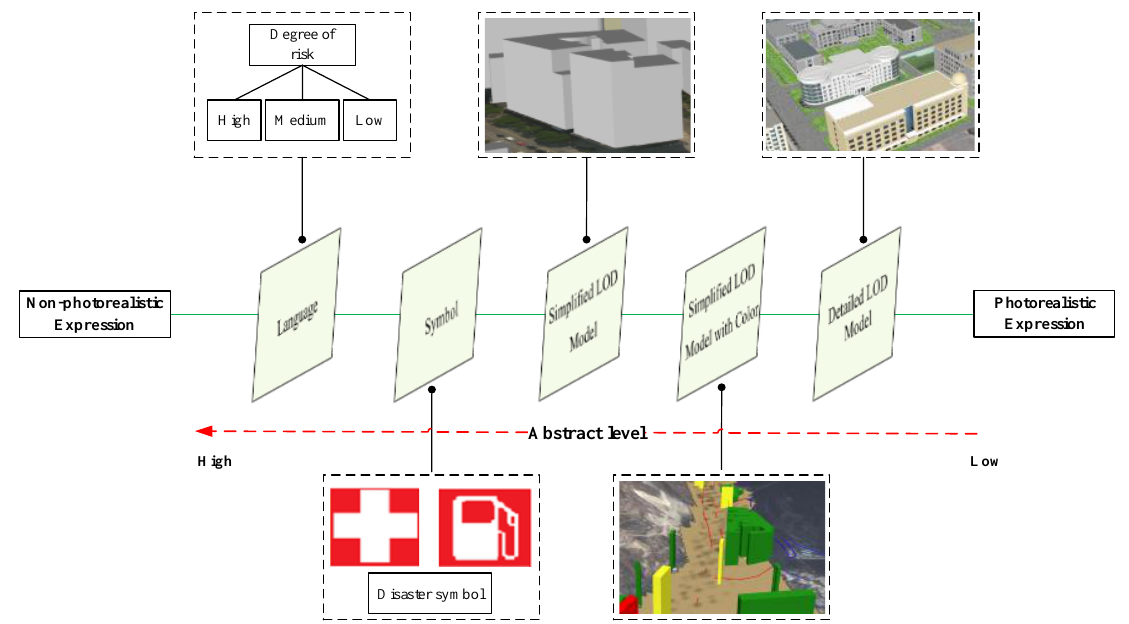
Figure 2. Continuous hierarchy of non-photorealistic and photorealistic expression.